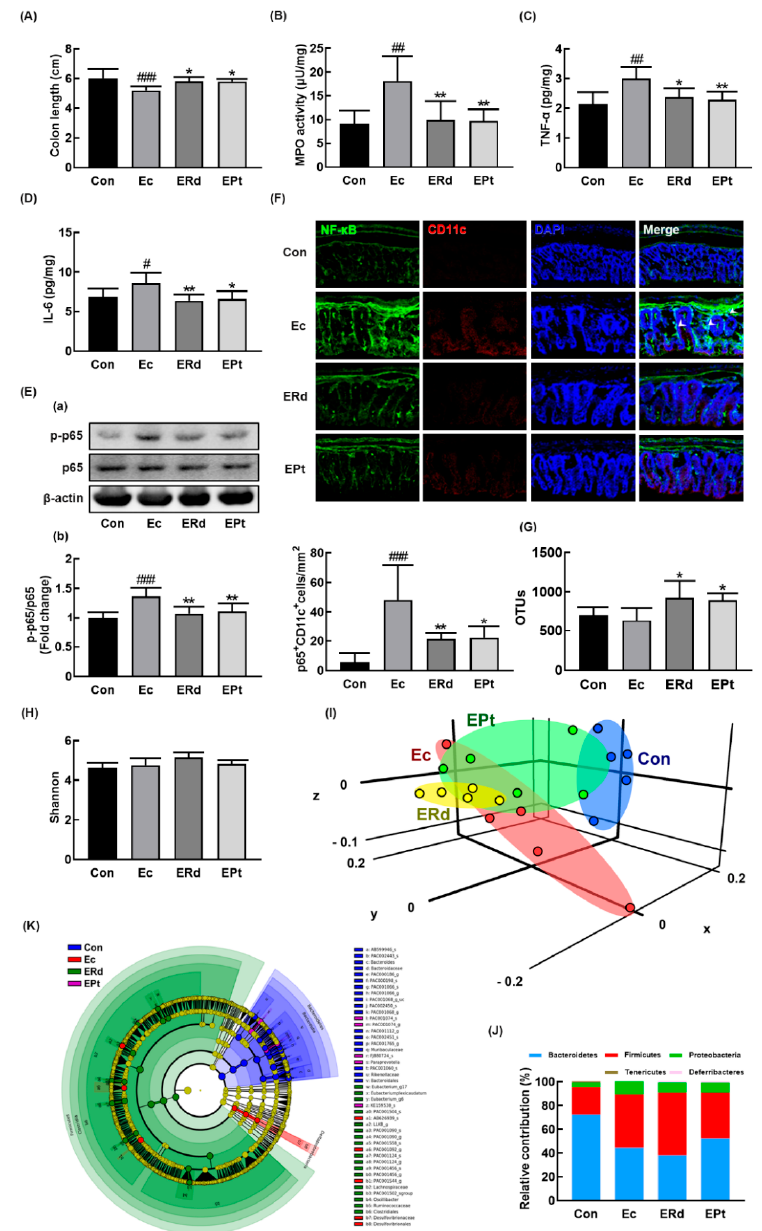
Figure 5. Oral administration of Rd or protopanaxatriol alleviated Escherichia coli K1 (EC)-induced colitis and gut dysbiosis in mice. Effects on colon length ( A ), myeloperoxidase (MPO) activity ( B ),